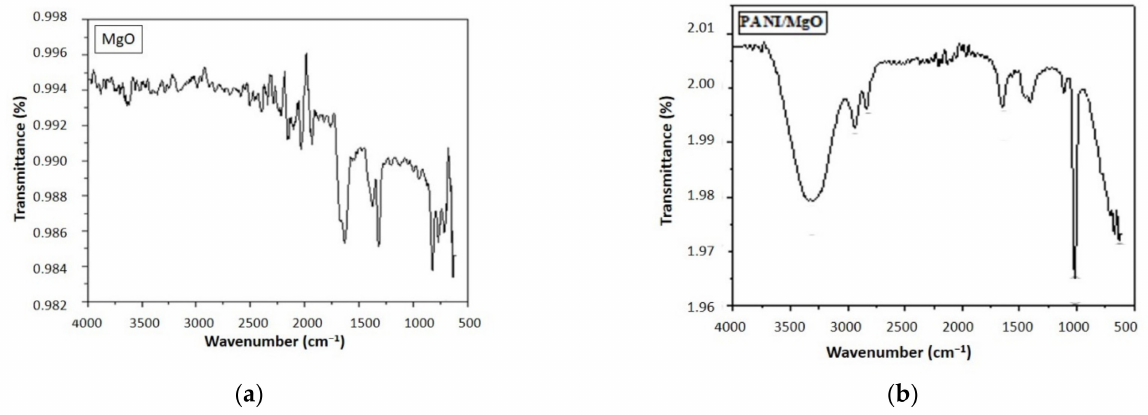
Figure 3. FTIR spectra of ( a ) MgO ( b ) PANI/MgO